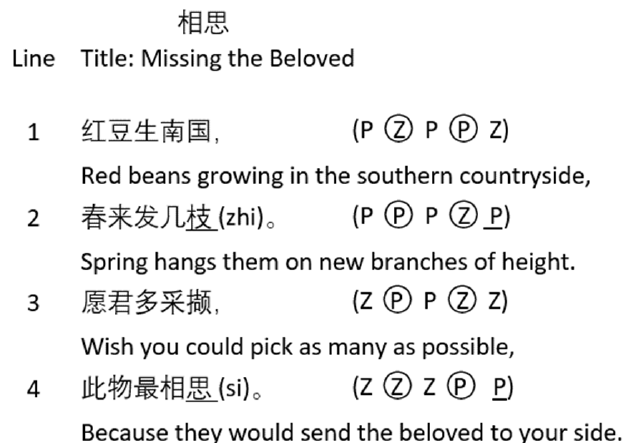
Figure 1. An example of a 5-character quatrain where P and Z represent Ping-tone and Ze-tone, respectively. The circled P and Z denote the key positions that must obey the basic tone rules. The underscored Ps represent these positions that must be rhymed.